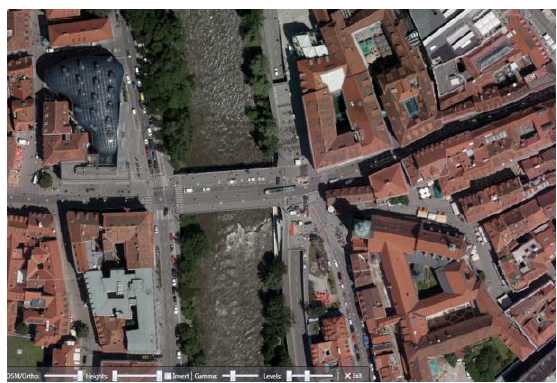
Figure 7. High resolution DSMOrtho, generated automatically by